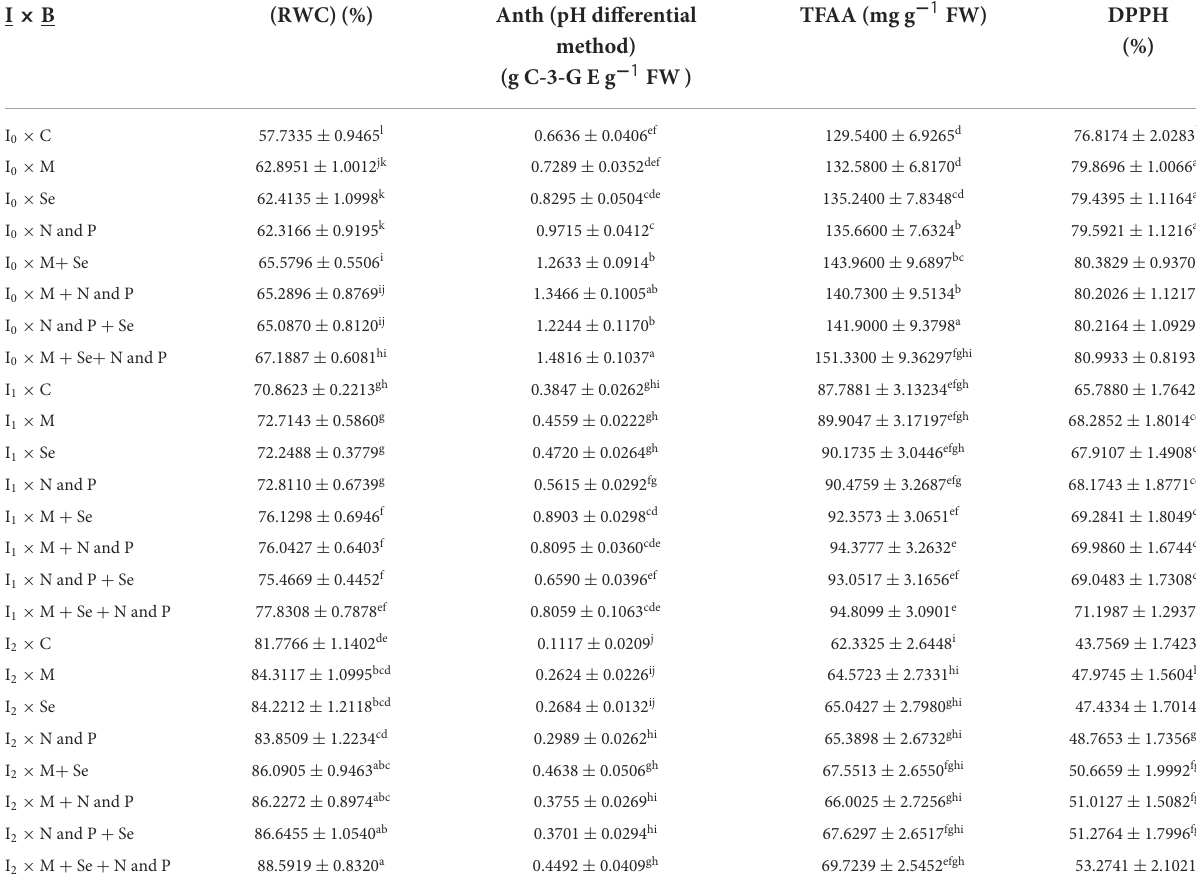
TABLE 4 Mean comparisons of the dual interactions of irrigation levels and bio fertilizers on RWC, Anth, TFAA, and DPPH traits in 2018–2019. I ×